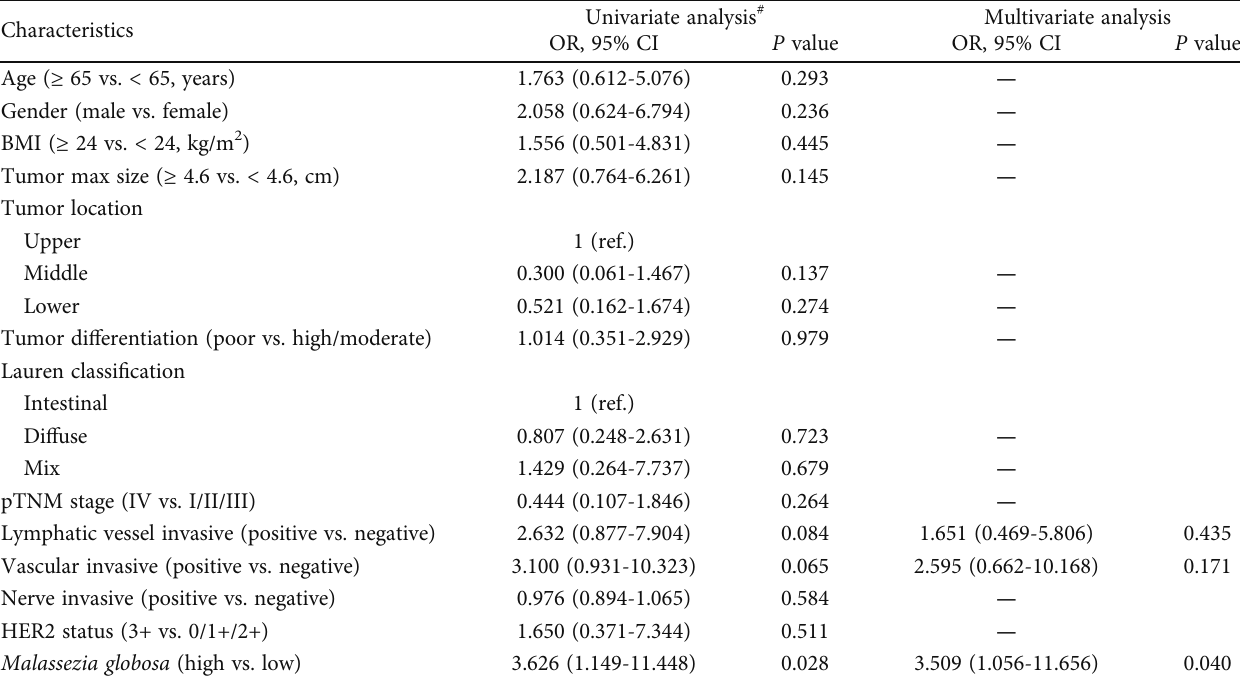
Table 2: The association of clinical characteristics with expression level of